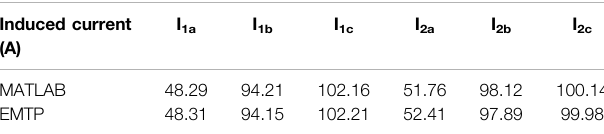
TABLE 2 | Simulation and theoretical calculation results of the induced current of the cable sheath Induced current